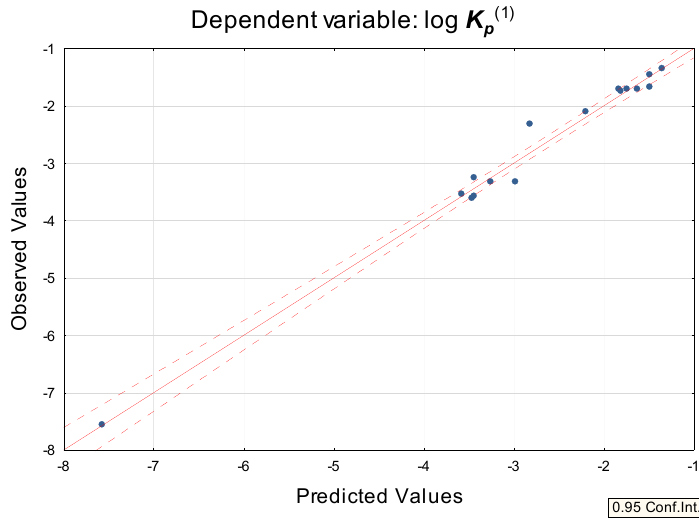
Figure 5. Equation (4) predicted vs. observed values.